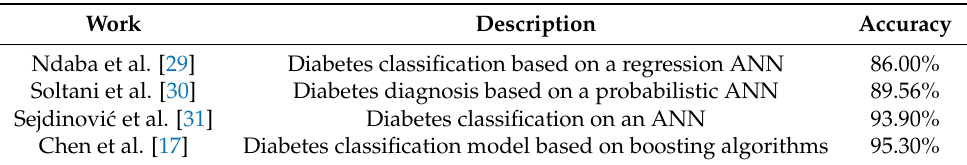
Table 4. Accuracy presented in related